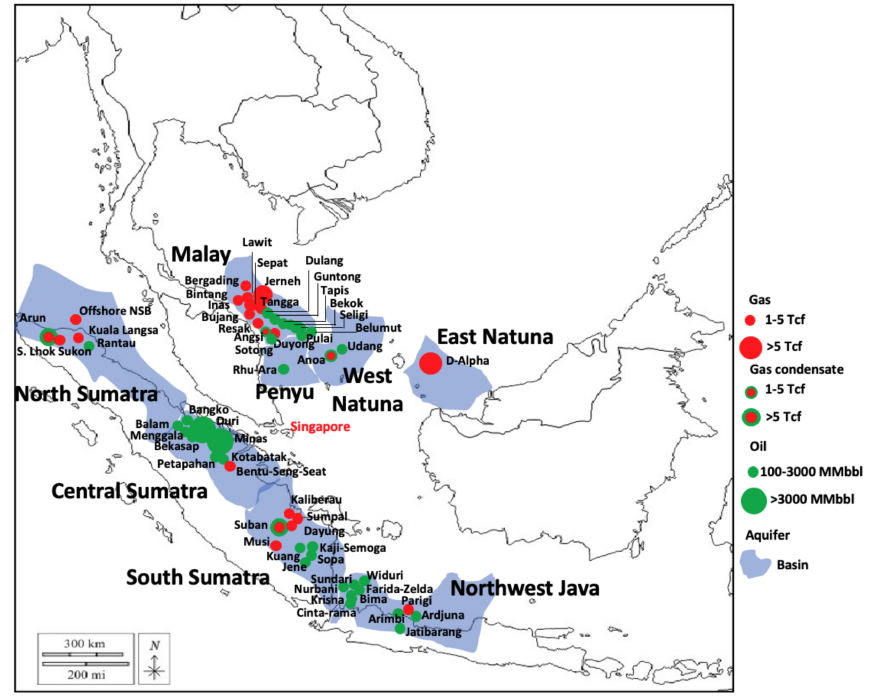
Figure 9. Sedimentary basins and oil and gas fields within 1000 km from